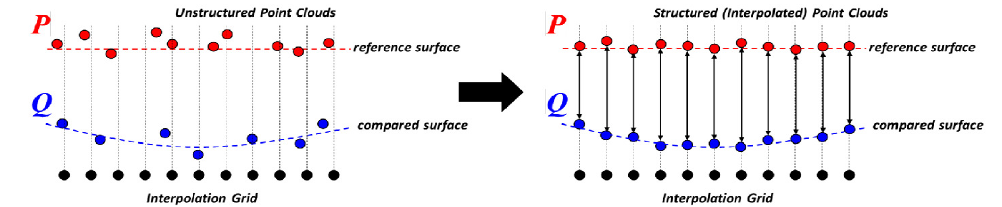
Figure 7. P2P distance metric